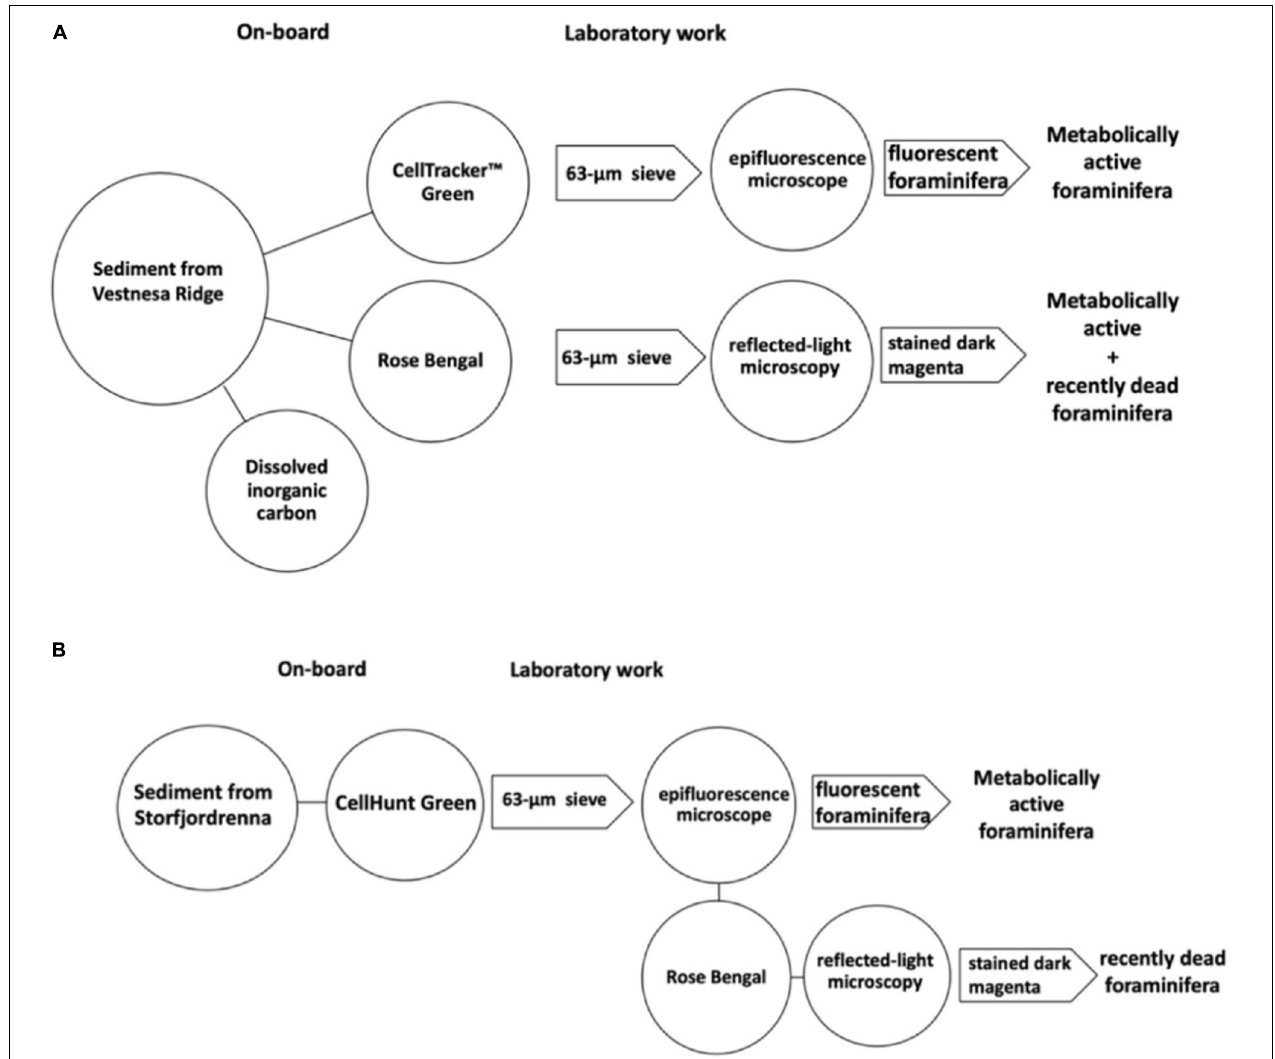
FIGURE 3 | On-board and laboratory processing of the sediment from Vestnesa Ridge (A) and from Storfjordrenna (B)